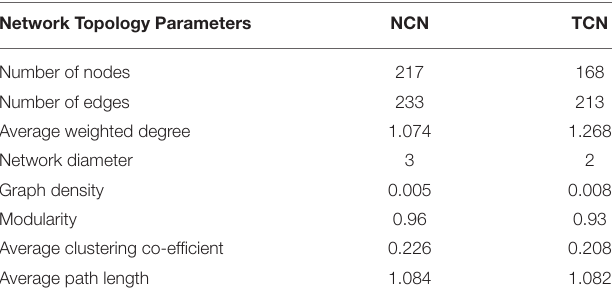
Network Topology Parameters